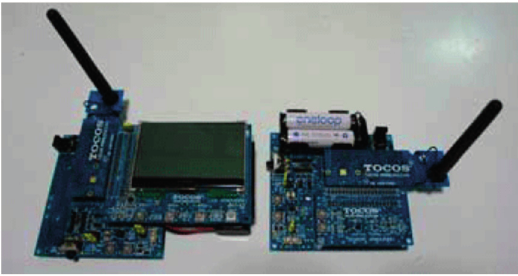
Figure 1. ZigBee module used in this